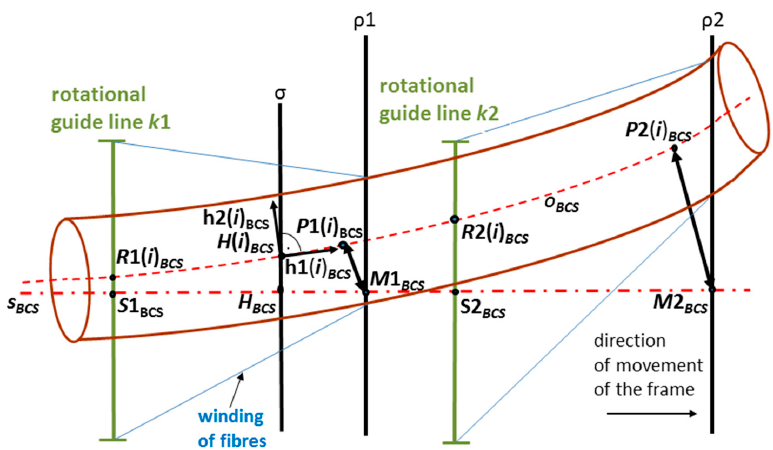
Figure 10. Front view of general scheme of non-bearing core frame passage through the fiber-processing head, axis s BCS of fiber-processing head is parallel to axis y BCS